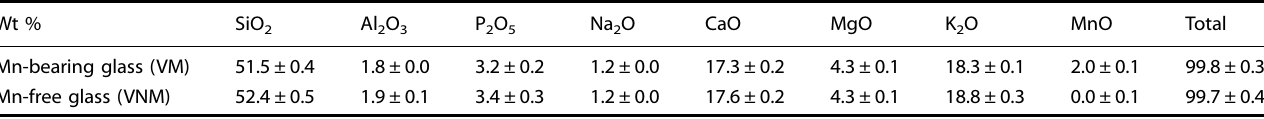
Standard deviations are calculated on 10 measurements performed on each